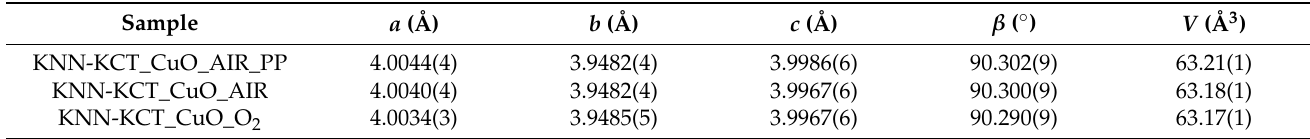
Table 1. Unit cell parameters of KNN-KCT-CuO thick